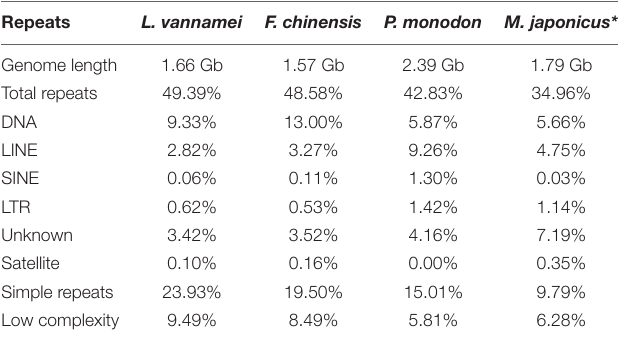
TABLE 1 | Summary of repetitive sequences in four penaeid shrimp